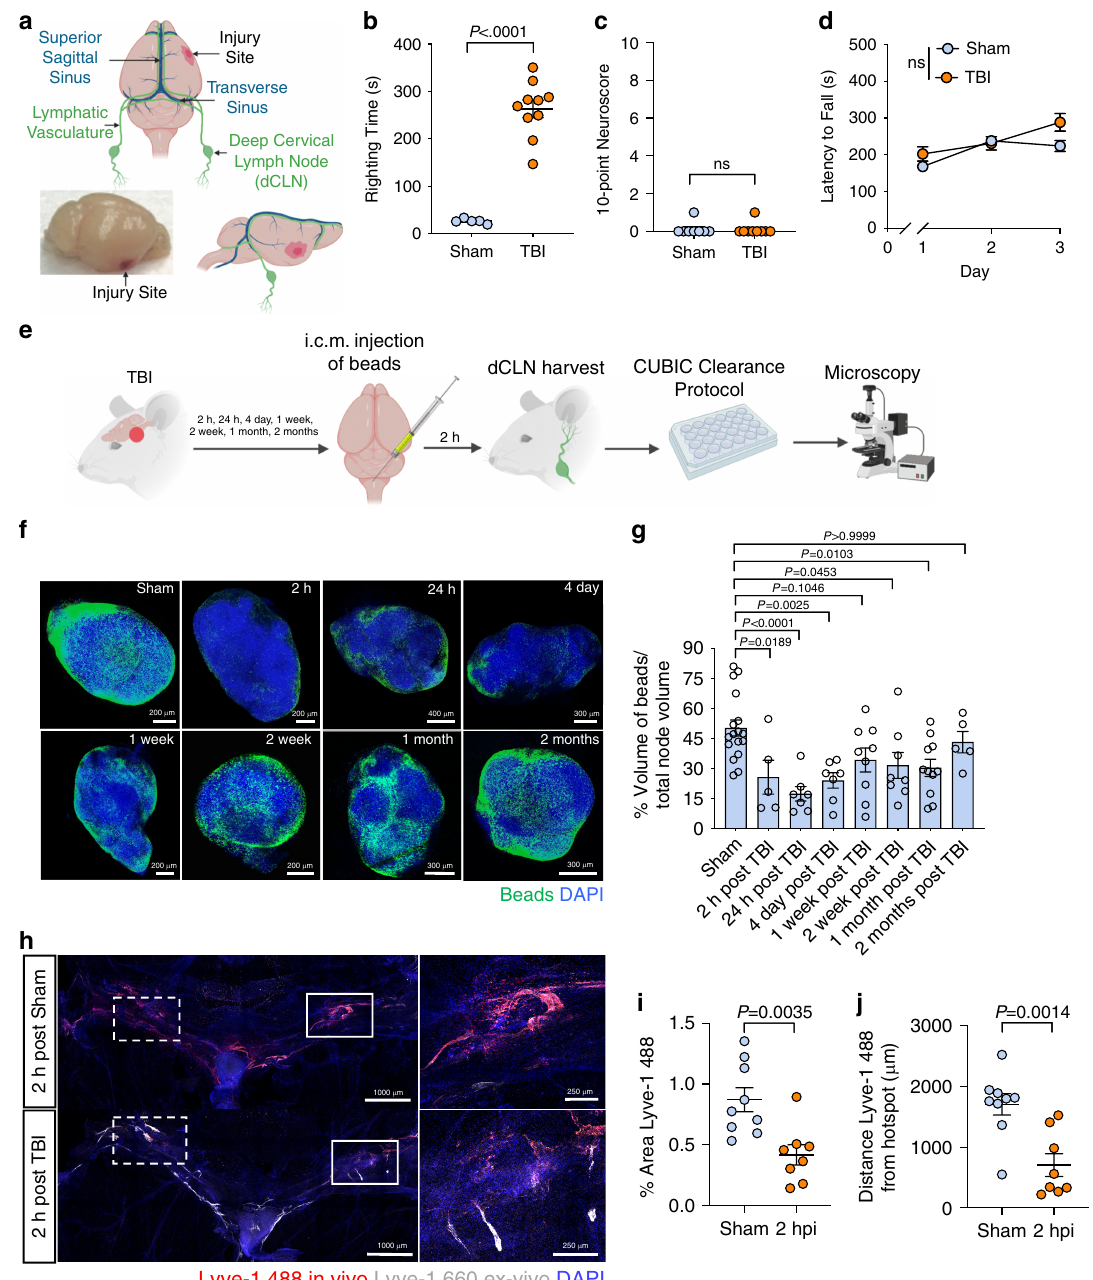
Fig. 1 TBI leads to impairments in meningeal lymphatic drainage. a Location of injury site in relation to the CNS lymphatic vasculature. b Righting times of TBI and sham mice (Sham n = 5, TBI n = 10; representative data from 10 independent experiments). c The 10-point gross neuroscore test 1 h after TBI (Sham n = 8, TBI n = 9; representative data from two independent experiments). d The accelerating rotarod behavioral test was used to assess motor function the fi rst 3 days after TBI ( n = 10 mice per group; representative data from two independent experiments). e Schematic of the experimental layout where mice received TBI and then were injected intra-cisterna magna (i.c.m.) with 0.5 μ m fl uorescent beads. f Representative images and g quanti fi cation of bead accumulation in the cleared dCLN at 2 h, 24 h, 4 days, 1 week, 2 weeks, 1 month, and 2 months post TBI. Each data point represents an average of the 2 dCLNs from an individual mouse (Sham n = 17, 2 h n = 5, 24 h n = 7, 4 day n = 7, 1 week n = 9, 2 weeks n = 8, 1 month n = 11, 2 months n = 5; pooled data from fi ve independent experiments). h Representative images of meningeal whole mounts 2 h after TBI stained for Lyve-1 488 (in vivo, red), Lyve-1 660 (ex vivo, gray), and DAPI (blue). Solid boxes show zoomed insets of the hotspots along the transverse sinus on the right. Dashed boxes indicate the other hotspots not featured in the inset. i ) Percent area of Lyve-1 488 (in vivo, red) coverage at 2 h post TBI or sham, and j distance traveled of Lyve-1 488 staining along the transverse sinus 15 min after injection (Sham n = 9, TBI n = 8; pooled data from two independent experiments). All n values refer to the number of mice used and the error bars depict mean ± s.e.m. P values were calculated by two-tailed unpaired Student ’ s t -test ( b , c , i , j ), repeated- measures two-way ANOVA with Bonferroni ’ s post hoc test ( d ), and one-way ANOVA with Bonferroni ’ s multiple comparison test ( g ). hpi, hour(s) post injury; h, hour(s); mo, month(s); wk, week(s). Source data ( b – d , g , i – j ) are provided as a Source data fi